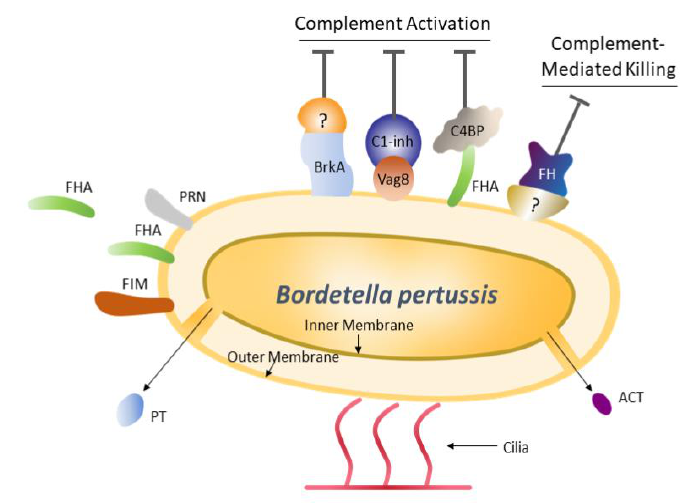
Figure 1. Immunological responses to Bordetella pertussis infection